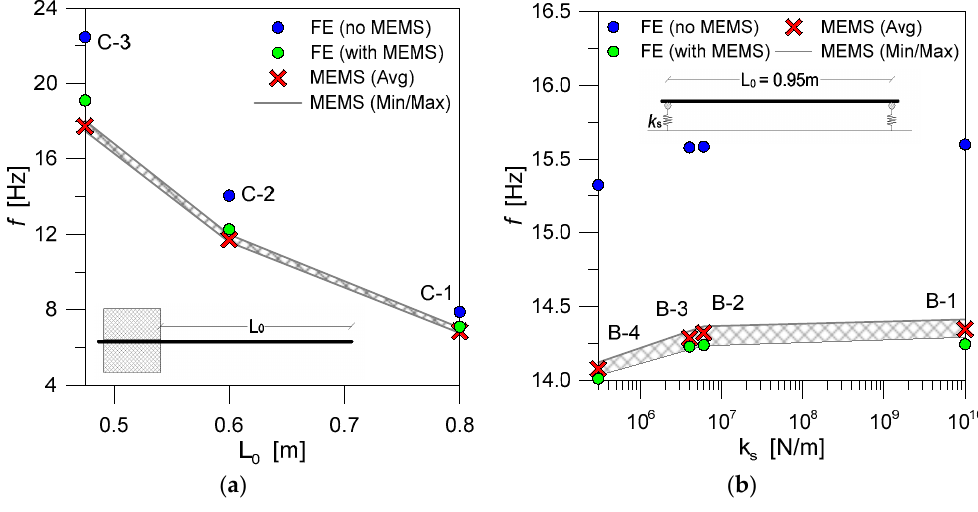
Figure 7. Experimental and numerical fundamental frequencies for ( a ) cantilever and ( b ) beam